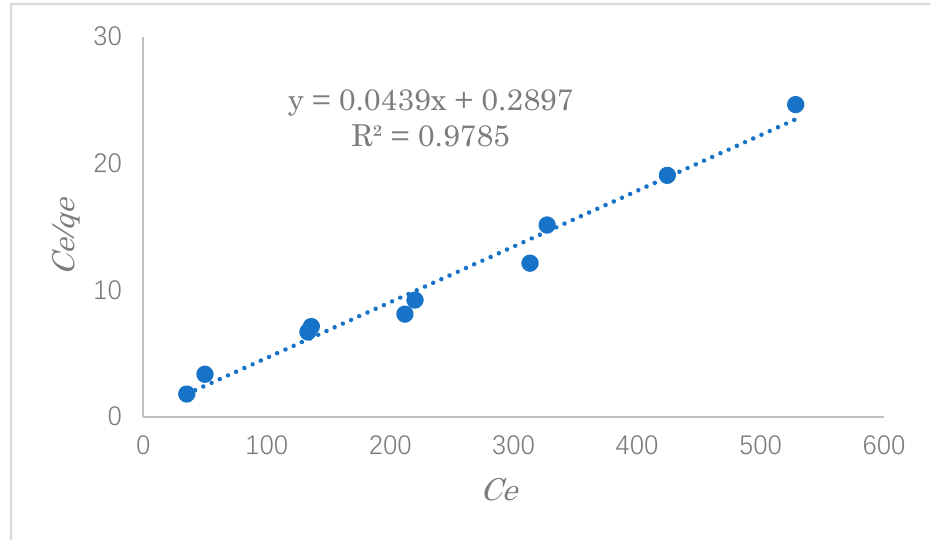
from the intercept of the Langmuir isotherm in Equation (4). K L represents the affinity strength of the adsorbent to the target substance [35].